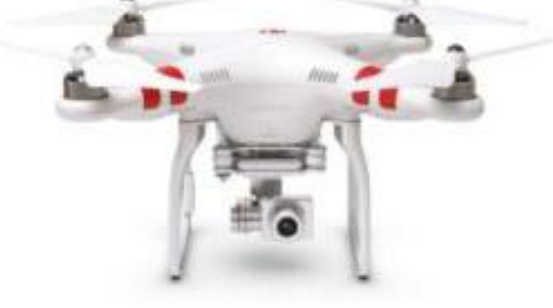
Figure 8. Aerial photogrammetry drone used on site was a Phantom 2 vision +,